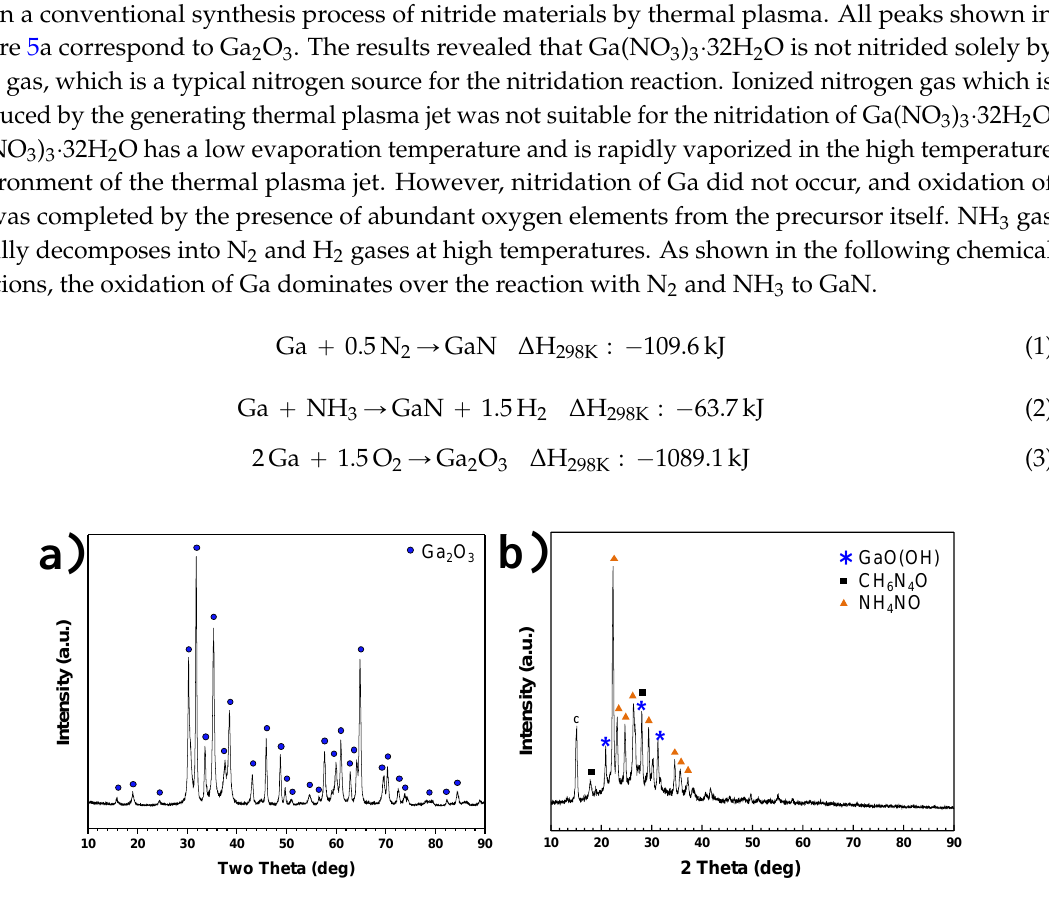
Figure 5. XRD (X-ray diffraction) pattern of product synthesized by thermal plasma; ( a ) Plasma 1 by Ga(NO 3 ) 3 ∙32H 2 O and NH 3 without C 3 H 6 N 6 ; ( b ) Plasma 2 by Ga(NO 3 ) 3 ∙32H 2 O and C 3 H 6 N 6 pellet with NH 3 gas.